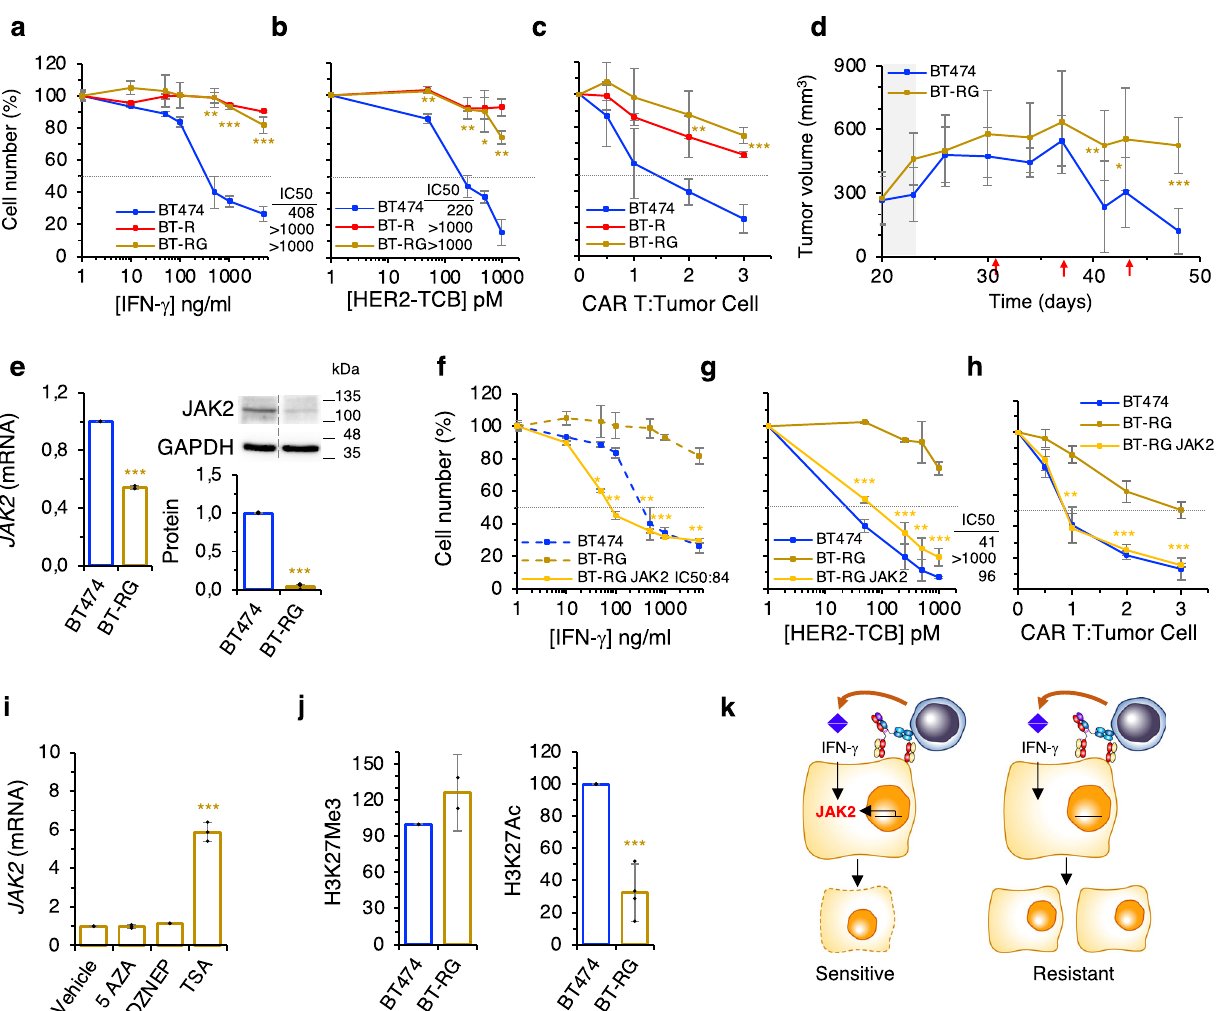
Fig. 6 Model of resistance to IFN- γ . a Parental BT474 cells or resistant BT-R or BT-RG cells were treated with different concentrations of IFN- γ for 5 days. Cell numbers were estimated with the crystal violet staining assay. b Cocultures of PBMCs with the indicated cells were treated with different concentrations of HER2-TCB for 72 h. Then, viable target cells were quanti fi ed by fl ow cytometry using EpCAM as a marker. c The same cells as in ( a ) were treated with different ratios of CAR T:Tumor cell. Cell numbers were obtained by means of EpCAM counts by fl ow cytometry. d Totally, 10 7 BT474 or resistant BT-RG cells were injected orthotopically into NSG mice. When tumors reached ~300 mm 3 (dark background), 10 7 PBMCs were injected i.p. Then animals were treated i.v. with 0.125 mg/kg HER2-TCB as indicated (red arrows). Tumor volumes are represented as averages ± SD (BT474, n = 8; BT-RG, n = 6). e The levels of JAK2 (mRNA and protein) as determined by quantitative real-time PCR (left) or Western blot (right). Results were normalized to BT474 cells. f – h The indicated cells were analyzed as in ( a – c ), respectively. i BT-RG cells were treated with indicated compounds for 48 h. Then, the levels of the mRNA encoding JAK2 were determined by RT-PCR and normalized to the levels in cells treated with vehicle. j Levels of H3K27Me3 and H3K27Ac histone marks in the promoter of JAK2 in BT474 and BT-RG cells as measured by ChIP followed by quantitative real-time PCR. Results were normalized to the levels of an IgG control antibody in each sample, and then normalized to the levels in BT474 cells. k Schematic drawing summarizing our fi ndings. a ** p = 0.002, *** p < 0.001. b ** p = 0.009, ** p = 0.006, * p = 0.013, ** p = 0.002. c ** p = 0.008, *** p < 0.001. e *** p < 0.001. f * p = 0.02, ** p = 0.004, ** p = 0.002, *** p < 0.001, ** p = 0.002. g ** p = 0.005, *** p < 0.001. h ** p = 0.0015, *** p < 0.001. i , j *** p < 0.001. Two-tailed t test. d * p < 0.05, ** p < 0.01, *** p < 0.001, two-way ANOVA and Bonferroni correction. Data are presented as mean ± SD of three ( a – c , e – i ), two ( j left) or four ( j right) independent experiments. Source data are provided as a Source Data fi 2.5 mM EDTA, 1% bovine serum albumin (BSA) (#A9647, Sigma-Aldrich), 5% to speci fi cally kill remaining PBMCs. The process was repeated several times. horse serum (#26050, Gibco)) in polypropylene V-bottom 96-well plates Resistant population was obtained after 6 months. (#651201, Greiner Bio-One). Twenty minutes later, samples were centrifuged Interferon-gamma resistant models were established by culturing cells in and cells were stained with the epithelial cell marker anti-human EpCAM presence of increasing IFN- γ (#300-02, Peprotech) concentrations, starting at 100 (#324212, BioLegend) at 1:300 concentration in FACS buffer in ice for 30 min. ng/ml and reaching 1 μ g/ml. In the three models (BT474-RG, PDX667-RG, and After a wash with 1× PBS, samples were resuspended in the viability marker PDX433-RG) resistance was obtained after 4 months of treatment. Zombie Aqua at 1:1000 (#423101, BioLegend) in 1x PBS and acquired on LSR Fortessa, using BD FACSDiva software (BD Biosciences). Number of T cell cytotoxicity assays . All target cells were seeded in 96-well fl at bottom plates alive cells was analyzed with FlowJo software (BD Life Sciences) by means of (0.01 ×10 6 cells/well) (#353075, Corning Life Sciences). Effector PBMCs were EpCAM counts. Gating strategy for tumor EpCAM + counts is shown in added to each well at the indicated ratio in PBMC medium. Different concentra- Supplementary Fig. 8. tions of HER2-TCB were added to the wells. The plates were incubated for 72 h. When treated with CAR Ts, target cells were seeded as described above. After At the endpoint cells were harvested with trypsin – EDTA (#25300096, Gibco) 24 h, effector CAR Ts targeting HER2 were added to each well at the indicated and resuspended in fl uorescence-activated cell sorting (FACS) buffer (PBS 1×,